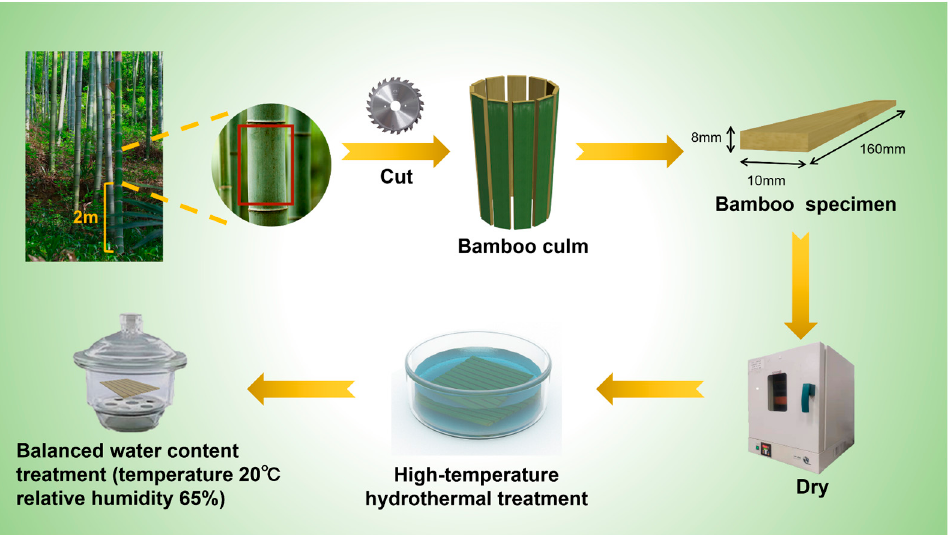
Figure 1. The high-temperature hydrothermal treatment process of moso bamboo specimens.